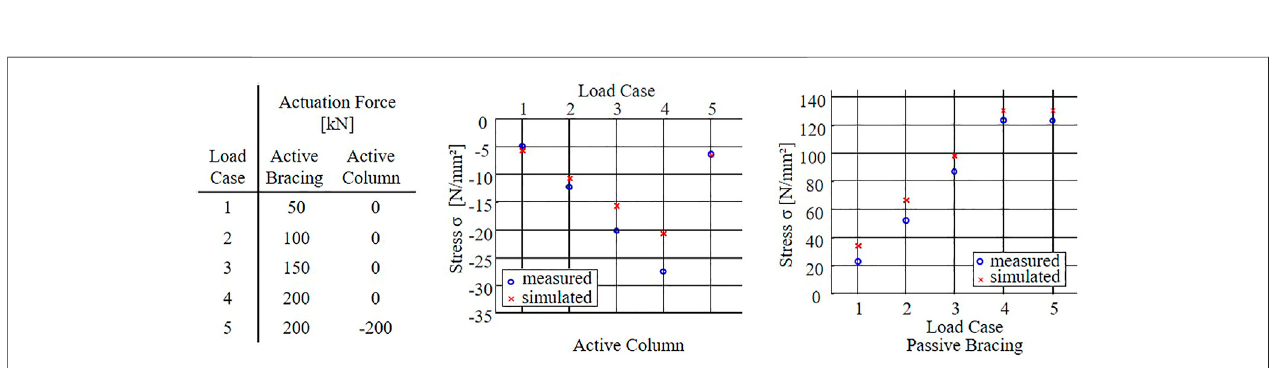
FIGURE 11 | Prototype test results (Source: (Weidner et al.,